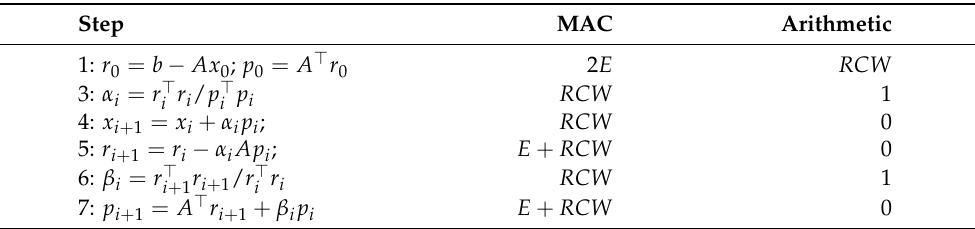
Table 2. Number of MAC and arithmetic operations needed for each step of Algorithm 1 considering the CSR format for A : E denotes the number of nonzero entries in A ; see Equations (10) and (11).